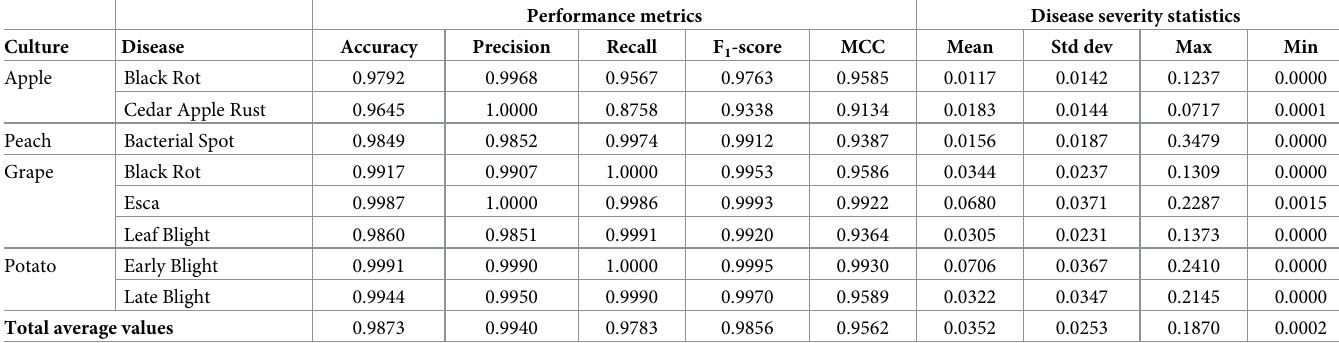
Table 4. Summary of the experimental results in terms of disease detection and disease severity estimation for each disease